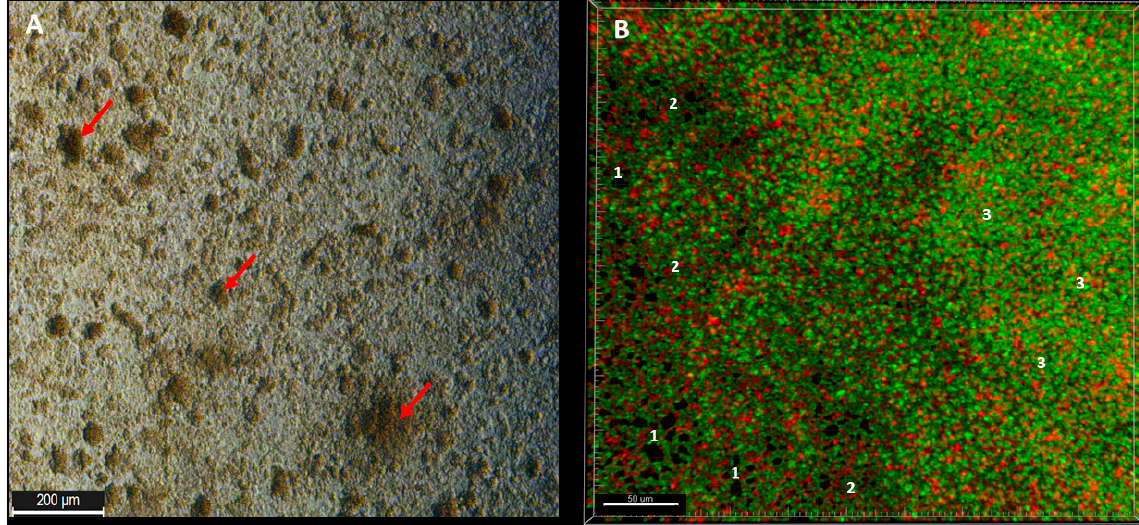
Figure 1. ( A )—Young, 12 h staphylococcal ATCC 6538 biofilm grown in a microplate (24-well) seen in an optical microscope (aerial perspective) without any prior preparative procedures; red arrows indicate areas of higher cellular density (mushroom-like structures); ( B )—aerial perspective of L/D-dyed, 24 h biofilm of the same strain. The “1s” show areas non-covered with cells (holes); the 2s” show areas of lower cellular density (of lower intensity of green color) than areas designated with “3s” (of higher density of green color). Red shapes are cells of decreased viability (with a compromised cell wall) or dead; while green shapes are viable cells (of non-compromised cell wall). Picture A, inverted microscope DMIL LED, magnification 10×; Picture B, confocal microscope SP8, magnification 40x.